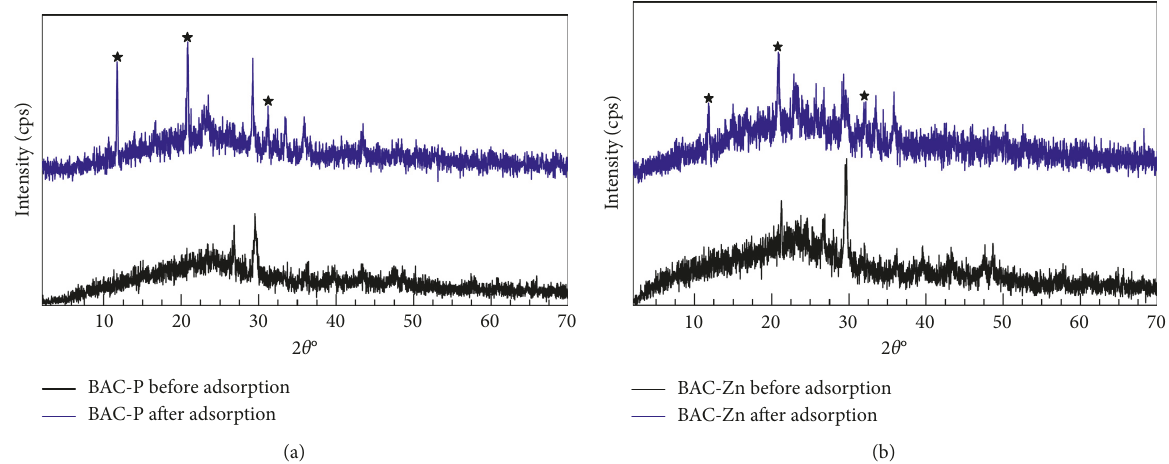
Figure 5: The XRD Patterns showing the (a) BAC-P adsorbent and (b) BAC-Zn adsorbent, before and after